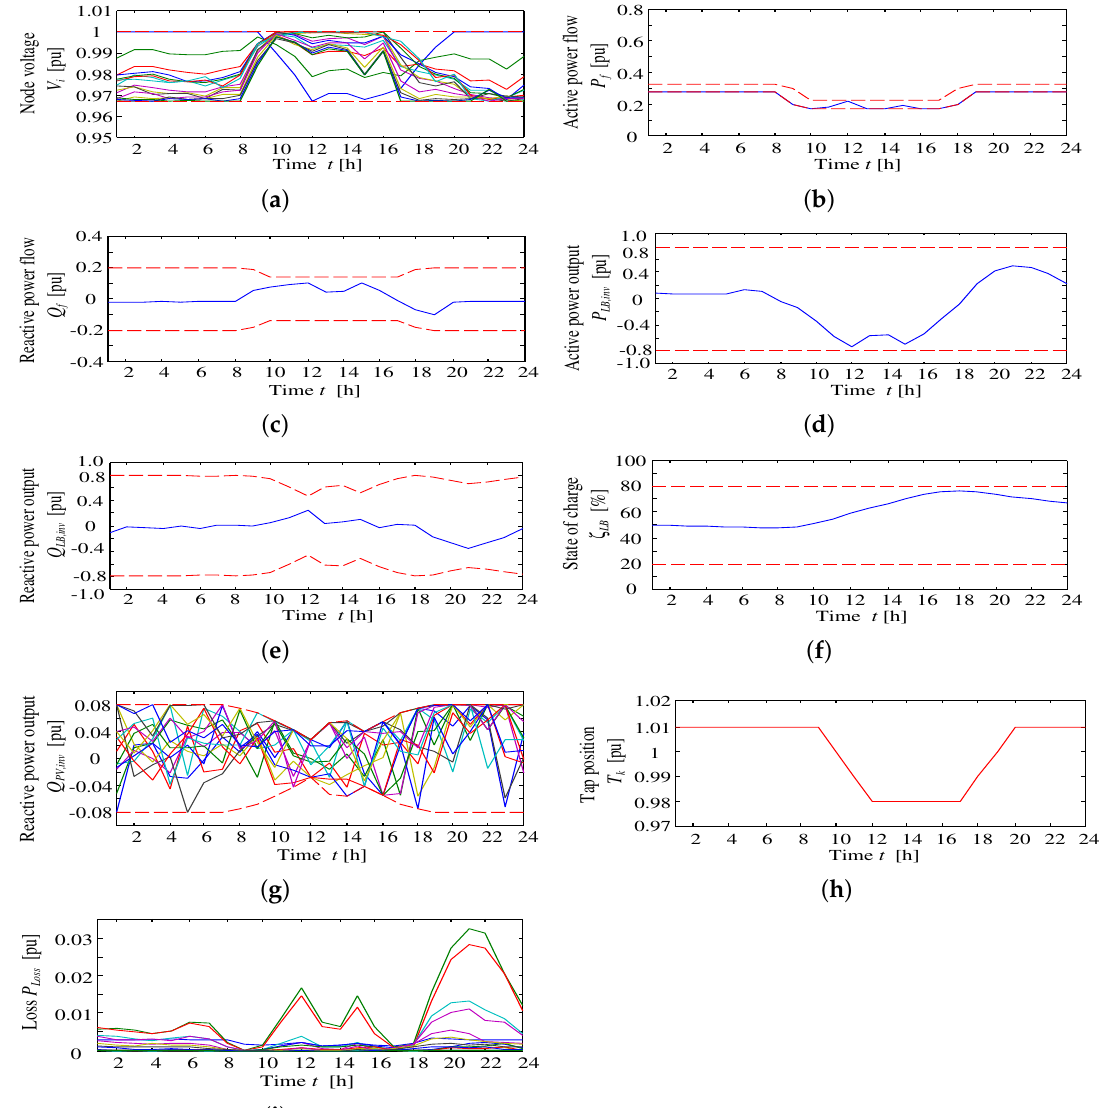
Figure 10. Simulation results of the comparison method (Case 3). ( a ) Voltage profile without control, ( b ) active power flow at the interconnection point and ( c ) reactive power flow at the interconnection point. ( d ) Active power output of large BESS. ( e ) Reactive power output of large BESS, ( f ) SOC of large BESS. ( g ) Reactive power compensation from the interfaced inverter of end-users. ( h ) Tap position of OLTC (LRT). ( i ) Distribution losses of each node over